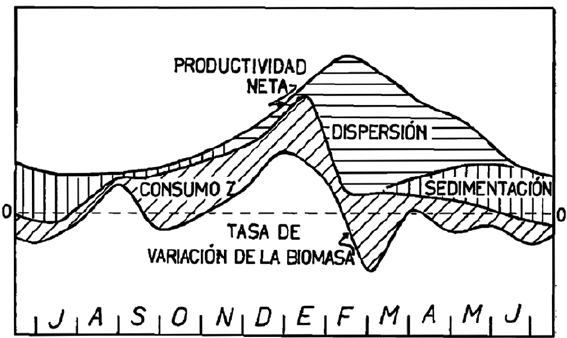
Fig. 1. – Theoretical and approximate interpretation of the sea- sonal cycle of phytoplankton in the waters of Castelló. Net primary production (“Productividad neta”) has been derived from the as- similation/respiration ratio (made proportional to (chlorophyll/dry weight)*exp(9000/RT); consumption by zooplankton (“Consumo Z”) has been considered to be proportional to the copepod density (data from Durán); the rate of variation of the biomass (“Tasa de variación de la biomasa”) has been directly calculated from the observed monthly means; the sedimentation (“Sedimentación”) is proportional to water stability; the dispersion (“Dispersión”) has been estimated by difference (From Margalef et al. 1957: Fig.